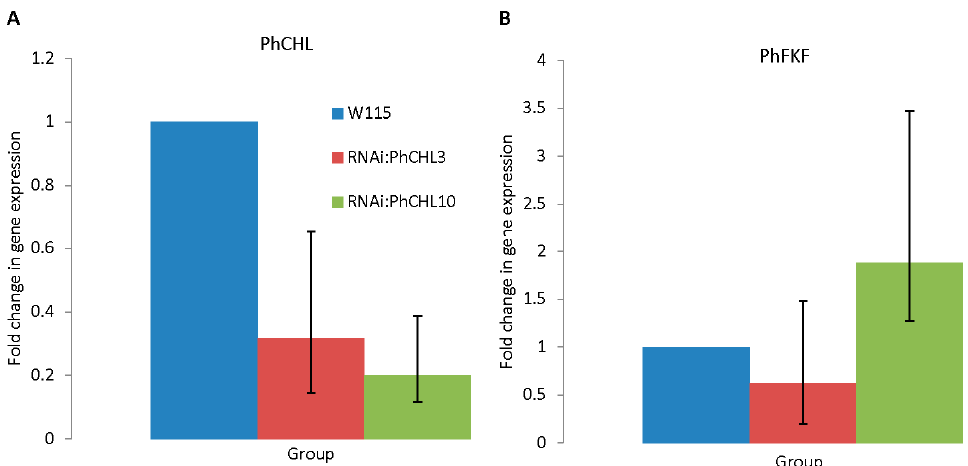
Figure 2. PhCHL ( A ) and PhFKF ( B ) expression in wild-type (blue bar) and RNAi:PhCHL plants (red bar and green bar) petals. PhCHL expression was significantly down-regulated in RNAi:PhCHL3 ( p = 0.047) and RNAi:PhCHL10 ( p = 0.032) compared to the wild-type ( A ). Silencing PhCHL did not a ff ect PhFKF expression RNAi:PhCHL3 ( p value = 0.6), RNAi:PhCHL10 ( p value = 0.06) ( B